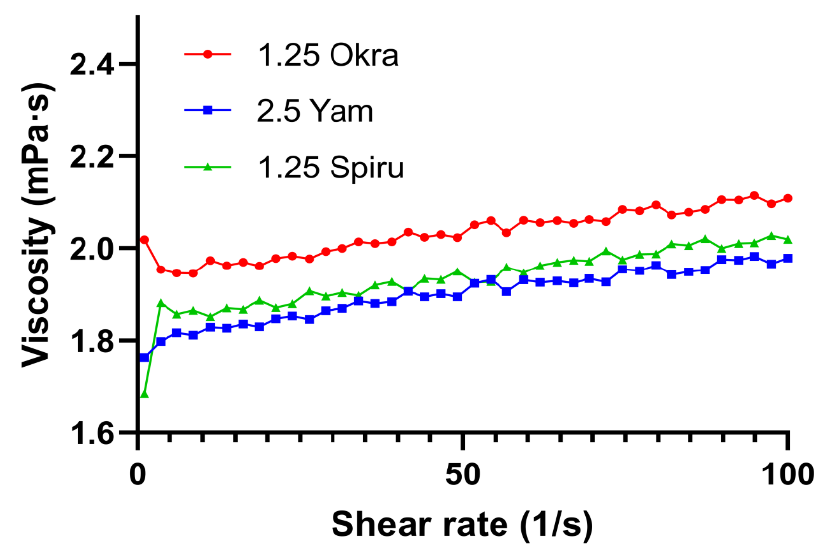
Figure 3. Rheological analysis of the three emulsions. Shear flow tests were carried out to study the viscosity with a shear rate ranging from 0.1 to 100 s −1 at 25 °C.